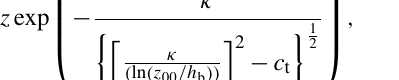
Figure 12. Same as Fig. 6 but for concentration differences between S4 run and the control run (S1), given by S4 −